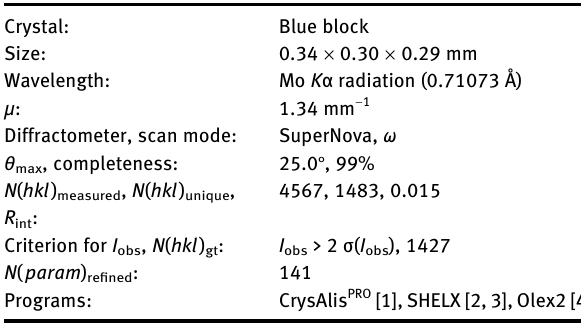
Table  : Data collection and